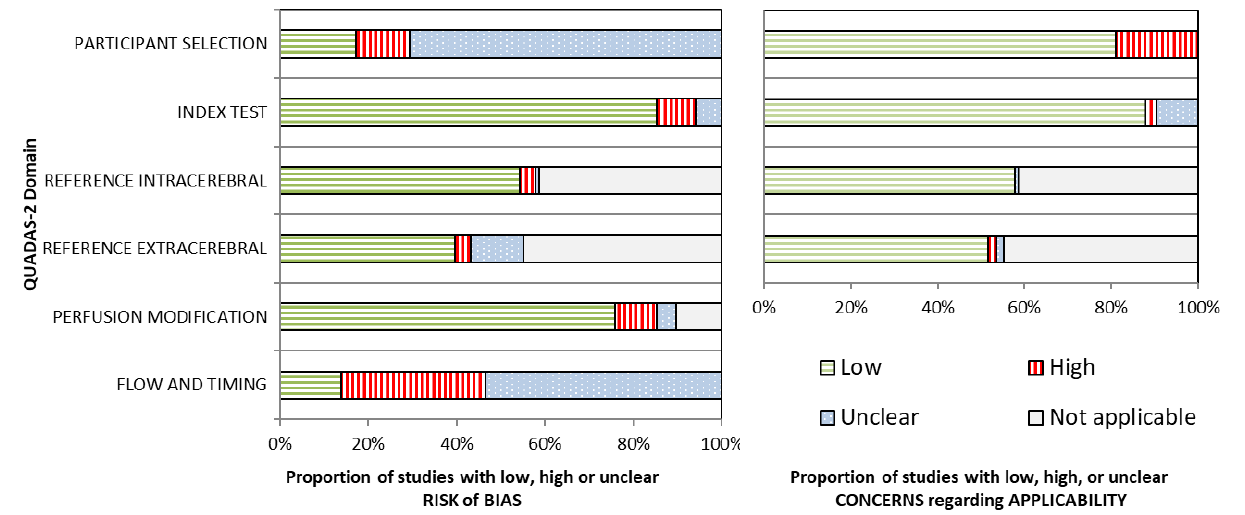
Figure 2. Critical appraisal results. Left panel: the proportion of 116 sub-studies that scored a low, high, or unclear risk of bias for each modified QUADAS-2 domain. Right panel: the proportion of 116 sub-studies for which there were low, high, or unclear concerns regarding applicability for each modified QUADAS-2 domain. Figure following the recommendations of Whiting and colleagues [17]. Detailed classification results are provided in Table S4. QUADAS-2, Quality Assessment of Di- agnostic Accuracy Studies, revised second version.